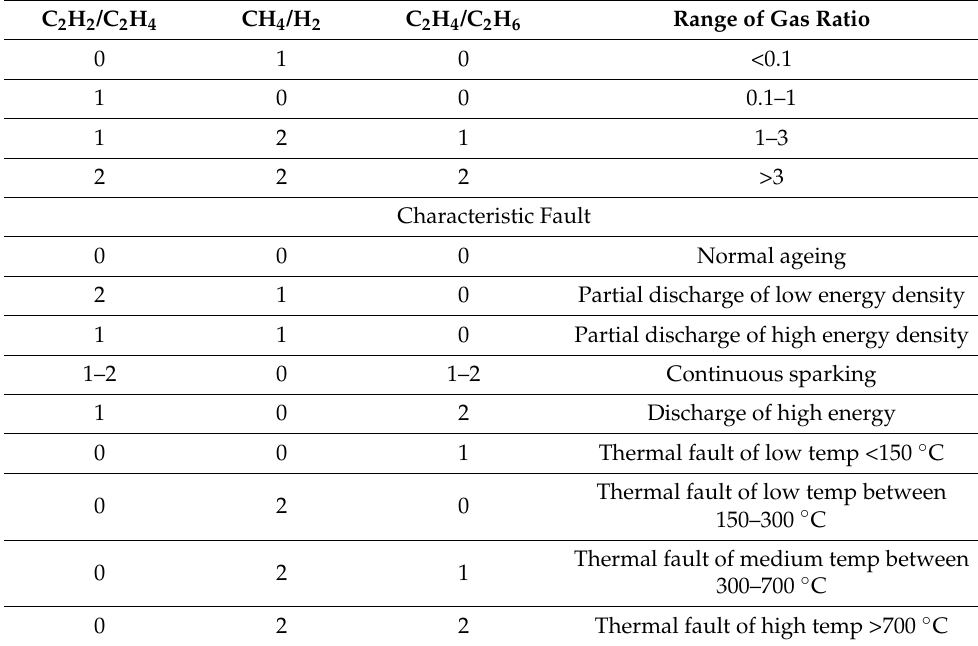
Table 4. Faults classification with Rogers’ ratio method.